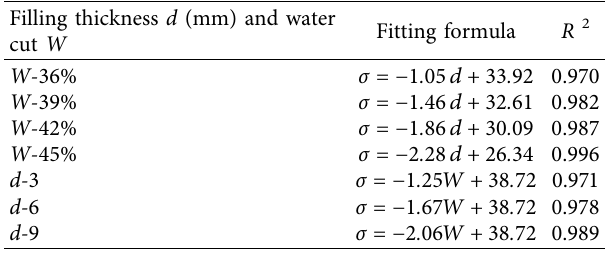
Figure 10: Variation in the dynamic compressive strength of the composite specimen. (a) Relationship between peak stress and flling medium thickness. (b) Relationship between the peak stress and water content of the flling medium. Table 1: Peak stress ftting curve.